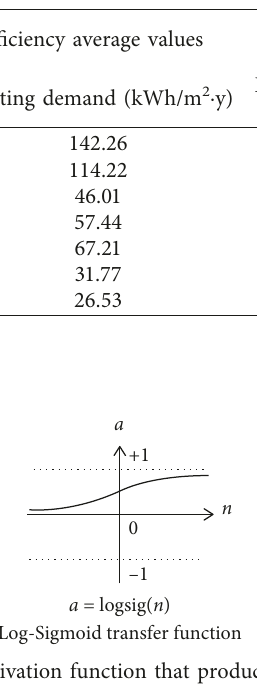
Table 2: Energy and environmental behavior summary for chosen building samples.